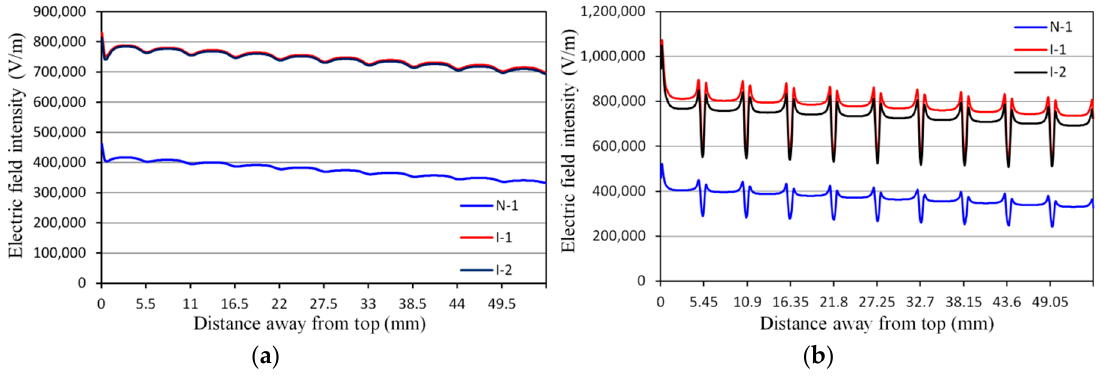
Figure 10. Electric field intensities on path 1 and path 2 for windings N-1, I-1 and I-2: ( a ) Electric field intensities on path 1; ( b ) Electric field intensities on path 2.